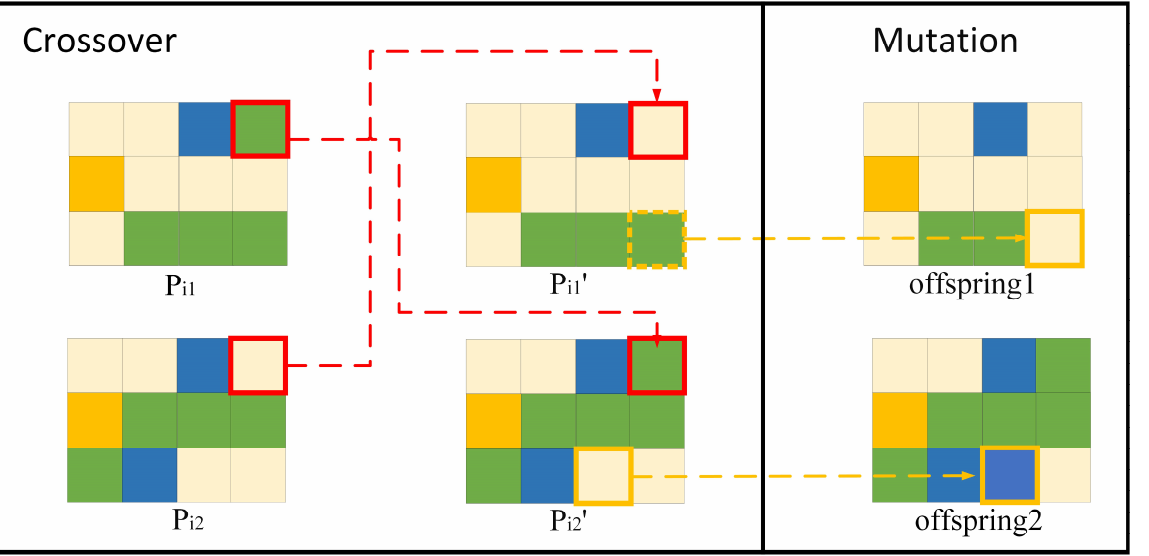
Figure 4. The process of crossover and mutation. Crossover is the interchange of land use types at selected cells in the two parents (P i1 and P i2 ). During the mutation, the selected units are randomly replaced with land use types. After the crossover and mutation, new offspring will be generated and continue to participate in the next iteration.